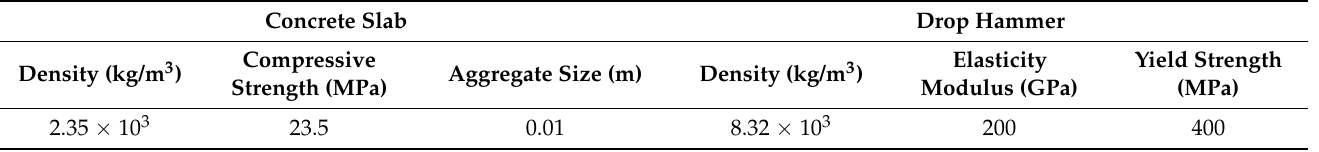
Table 1. The parameters of